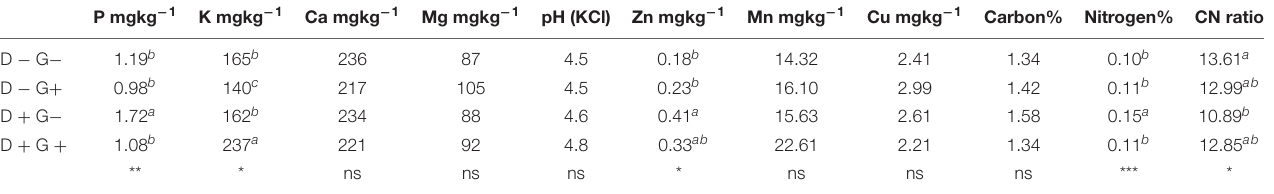
TABLE 3 | Soil chemical parameters (0–30 cm) as influenced by the interaction effects of drought and